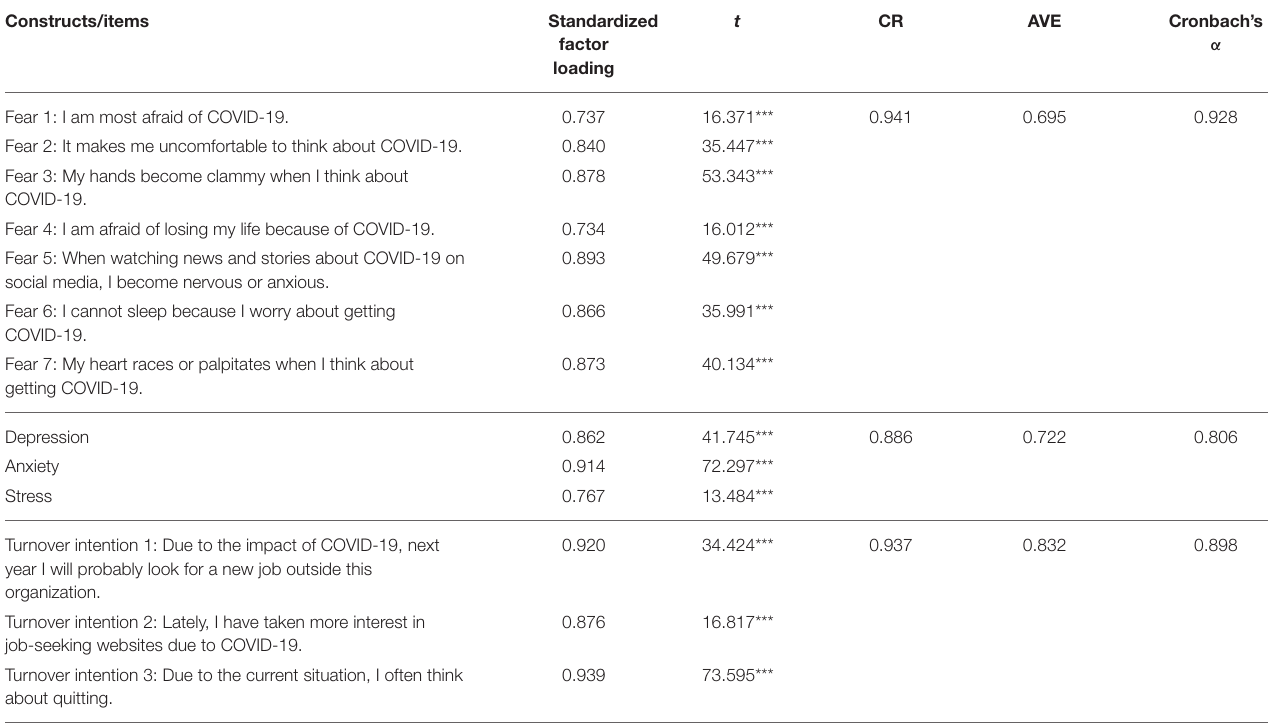
TABLE 3 | Measures of constructs reliability.